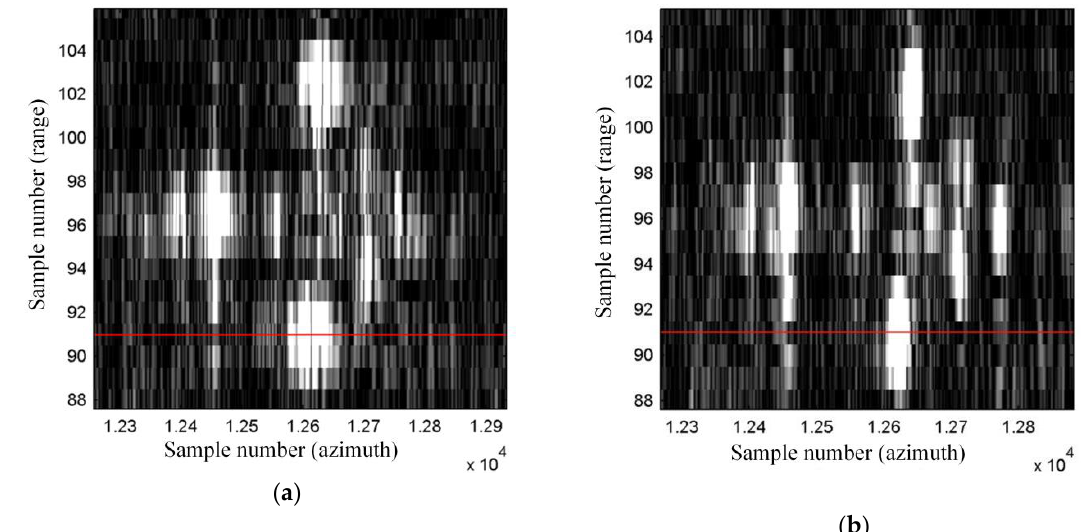
Figure 16. Image of the arrow made of corner reflectors: ( a ) with the INS/GPS-based MOCO, ( b ) with the MINS-based MOCO; red line—an analyzed row.